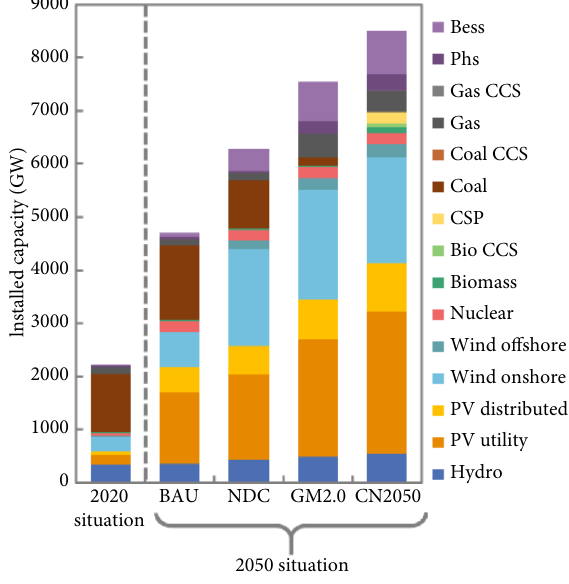
Fig. 1 Comparison of the capacity mix between different carbon emission scenarios and the current status in 2020 (reprinted with permission from ref. [1], © The Author(s)